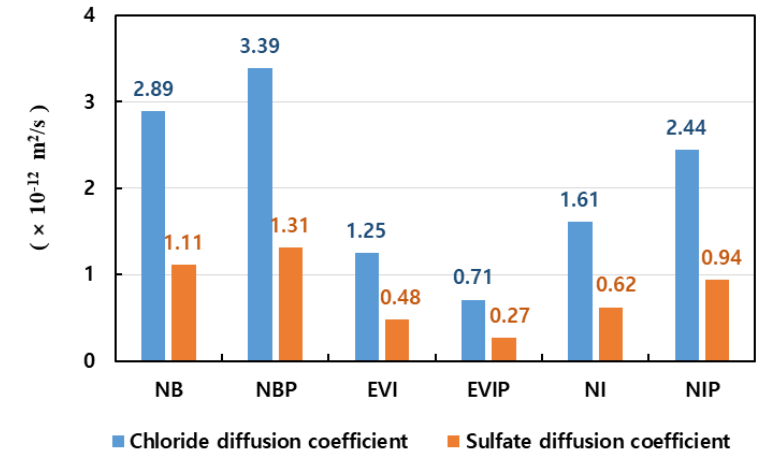
Figure 3. Results from chloride di ff usion coe ffi cient in various slime coating conditions. NB: Non-Bacteria; NBP: Non-Bacteria-Polymer; EVI: EV-Immob; EVIP: EV-Immob-Polymer; NI: Non-Immob; NIP: Non-Immob-Polymer.